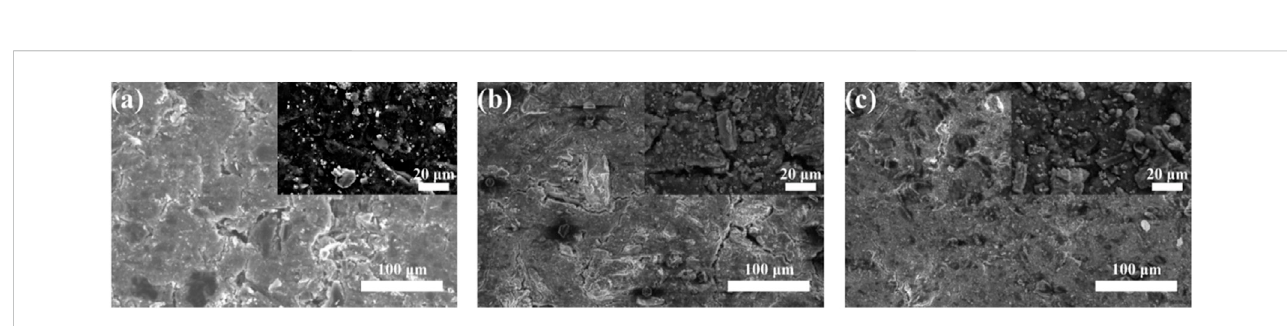
FIGURE 9 SEMimagesoftheCo 3 O 4 /CBaircathodesbeforeandaftercycling,respectively,withcorrespondinghigh-magni fi cationSEMimagesintheinset. (A) SEM image of the Co 3 O 4 /CB air cathodes before cycling. SEM images of Co 3 O 4 /CB air cathodes after cycling at (B) 4% DOD, (C) 75%